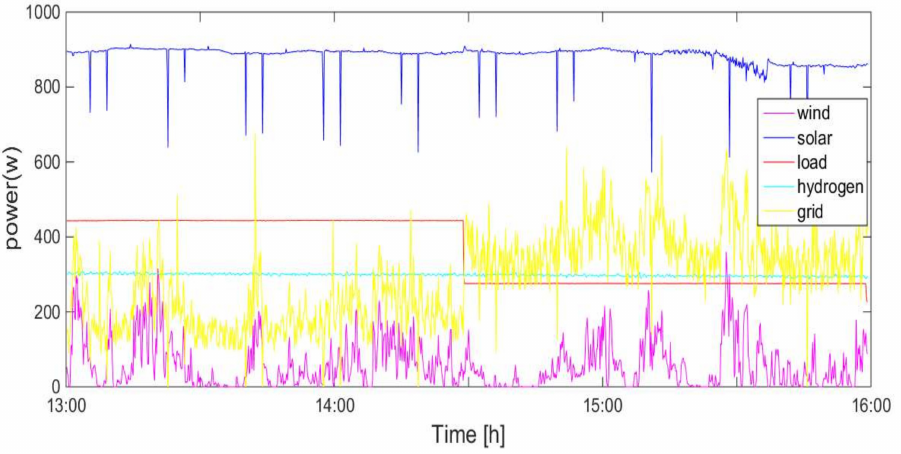
Figure 13. Power curves in scenario 2 (grid-connected).